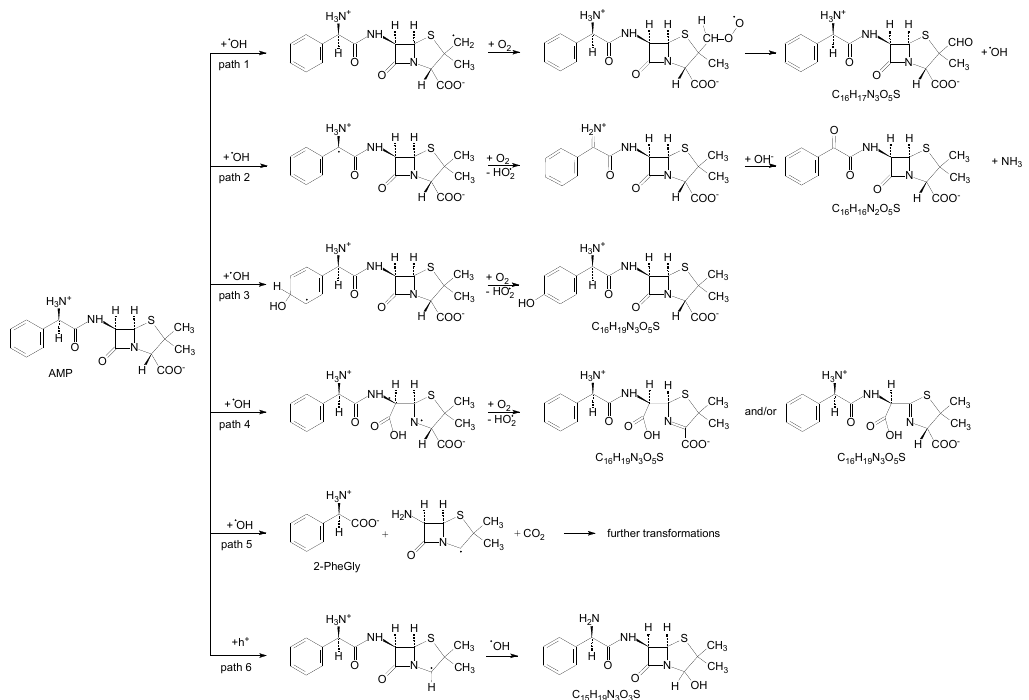
Figure 6. Mechanism of photocatalytic degradation of ampicillin including the identified primary products by UPLC/MS/MS.